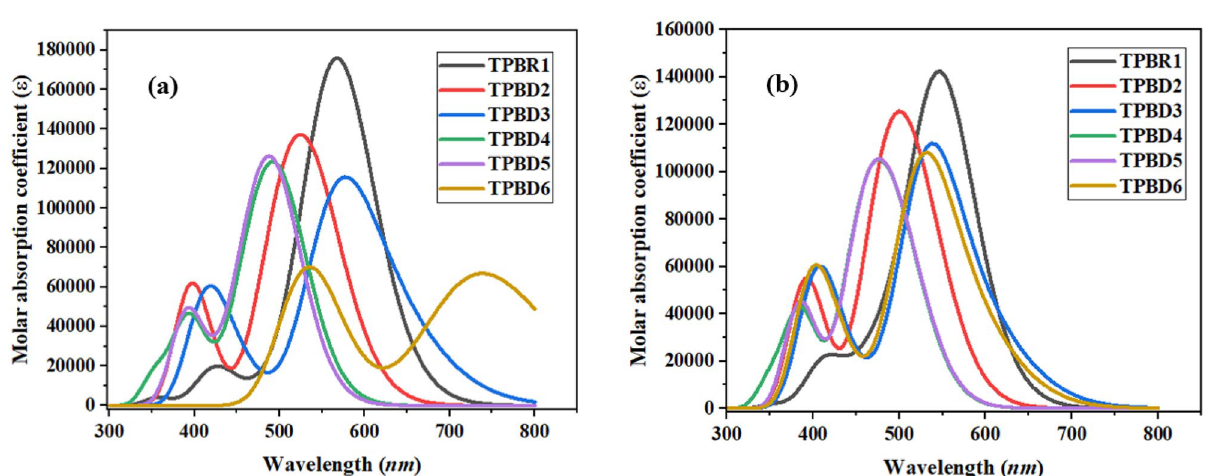
Figure 3. Absorption spectra of entitled compounds in chloroform ( a ) and gas phase ( b ). These graphs are drawn by utilizing Origin Pro 8.5 version (https:// origi npro. infor mer. com/8. 5/). All out put flies of entitled compounds were computed through Gaussian 09 version D.01 (https:// gauss ian. com/ g09ci